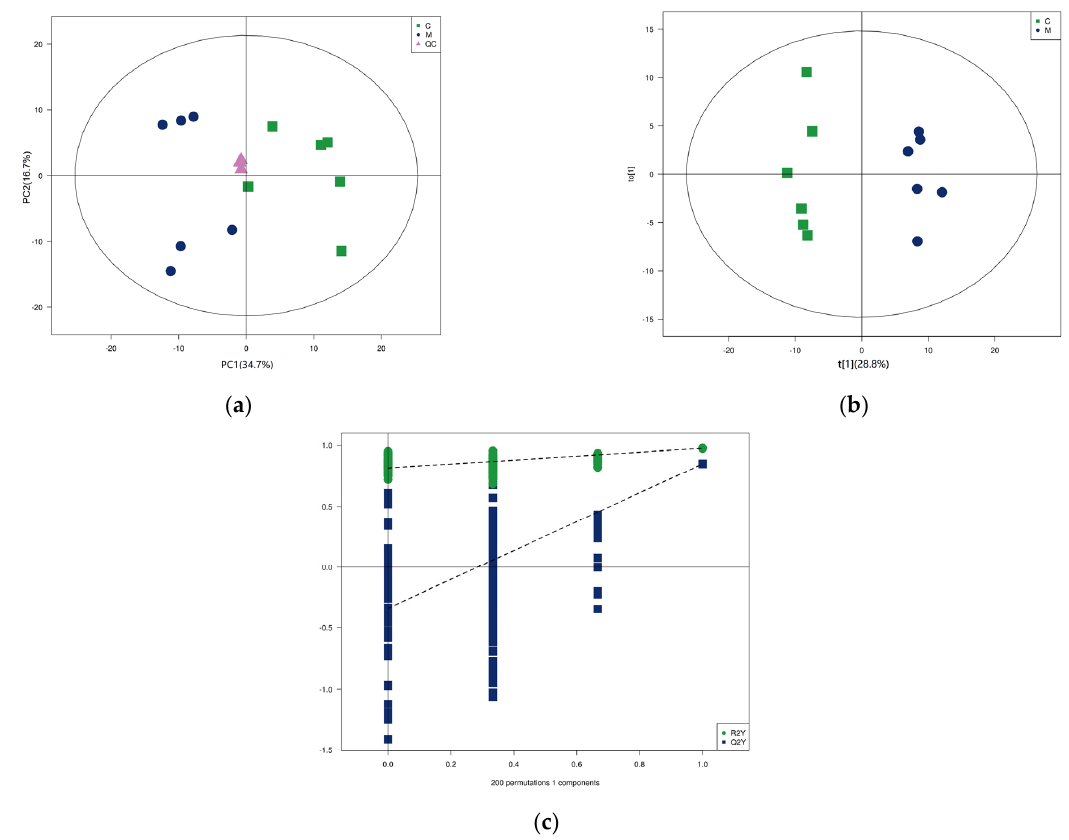
Figure 2. ( a ) The score plots of the principal component analysis (PCA) of lipids in yak colostrum, mature milk, and quality control (QC) samples. Green, blue, and red represent the samples of yak colostrum, mature milk, and QC, respectively. ( b ) The score plots of the orthogonal partial least squares discriminant analysis (OPLS − DA) of lipids in yak colostrum and mature milk. Green and blue represent the samples of yak colostrum and mature milk, respectively. ( c ) Permutation test of OPLS − DA